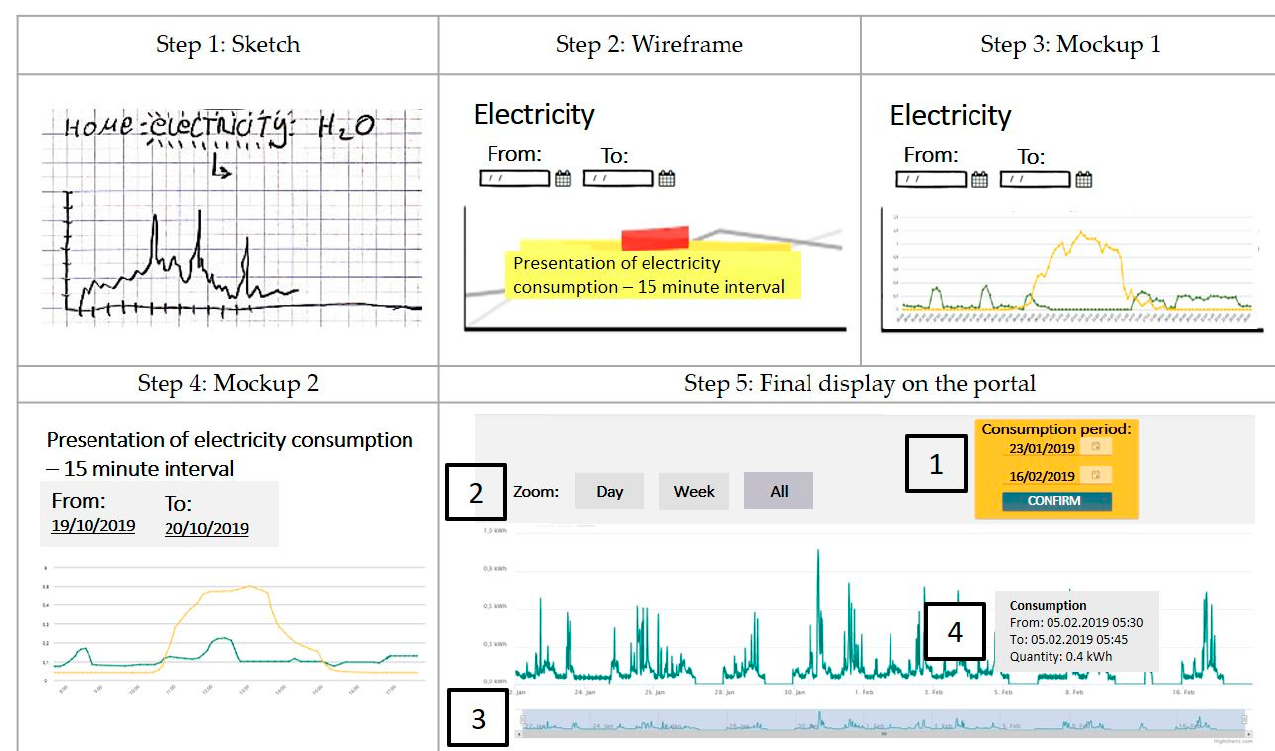
Figure 7. Process of designing electricity consumption feedback in (near) real time.